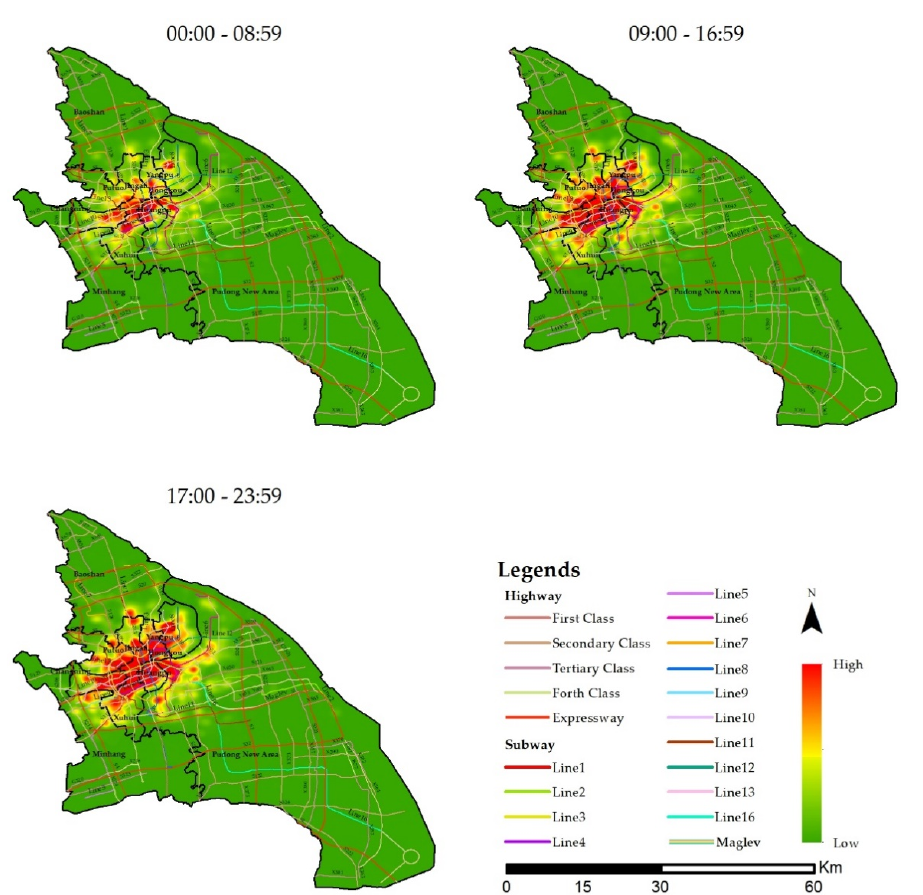
Figure 6. Check-in density for different hours of the Figure 6. Check ‐ in density for different hours of the day.